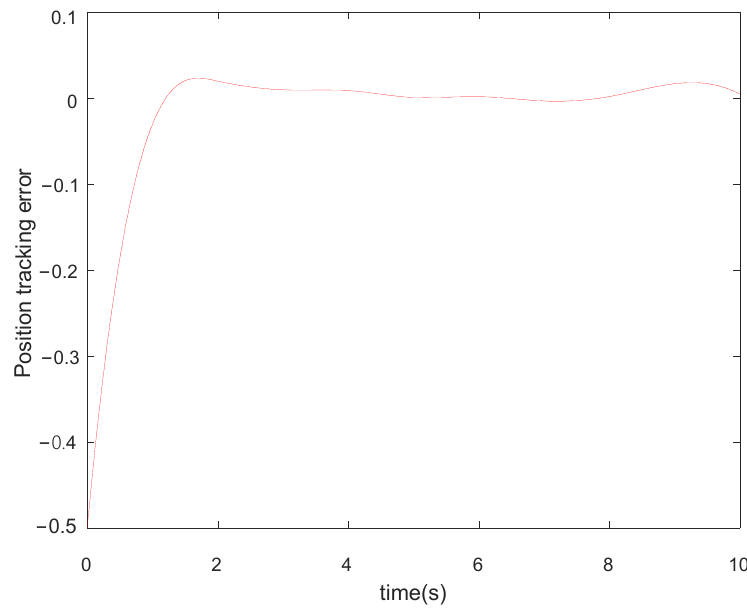
Figure 4. Position tracking error curves without error compensation.